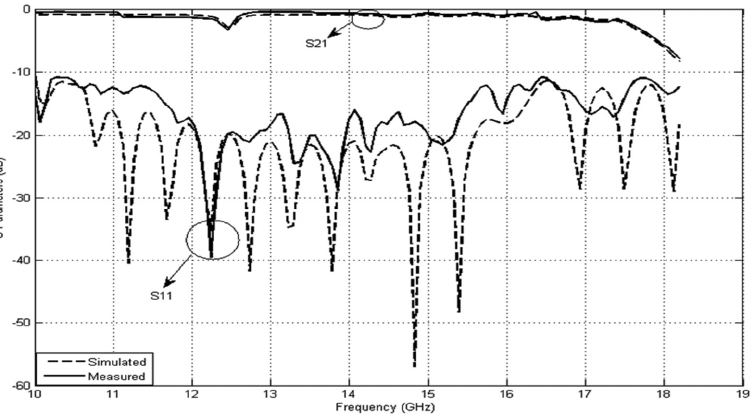
Figure 6. Simulated and measured S 11 and S 21 parameters for SIW LWA achieved from the measurements.